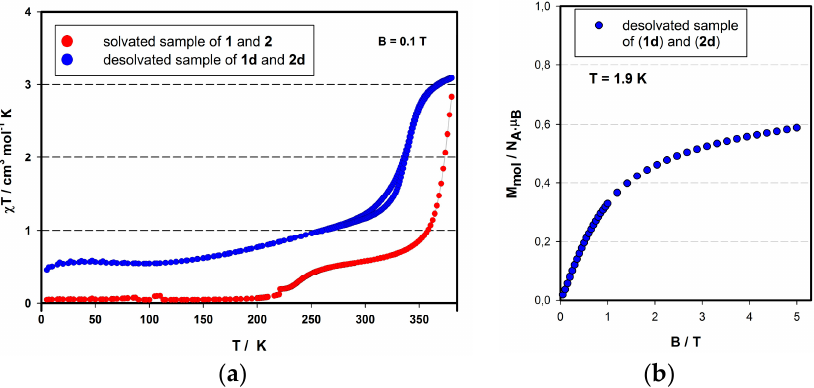
Figure 4. ( a ) Temperature-dependent magnetic properties of solvated (red circles) and desolvated (blue circles) mixture of compounds ( 1 ) [Fe( L ) 2 ](BF 4 ) 2 ·CH 3 CN and ( 2 ) [Fe( L ) 2 ](BF 4 ) 2 ·2CH 3 CN; ( b ) Field-dependent (blue circles) mixture of compounds ( 1 ) [Fe( L ) 2 ](BF 4 ) 2 ¨ CH 3 CN and ( 2 ) [Fe( L ) 2 ](BF 4 ) 2 ¨ 2CH 3 mole magnetization of desolvated sample at 1.9 K (mixture of ( 1d ) and ( 2d )).